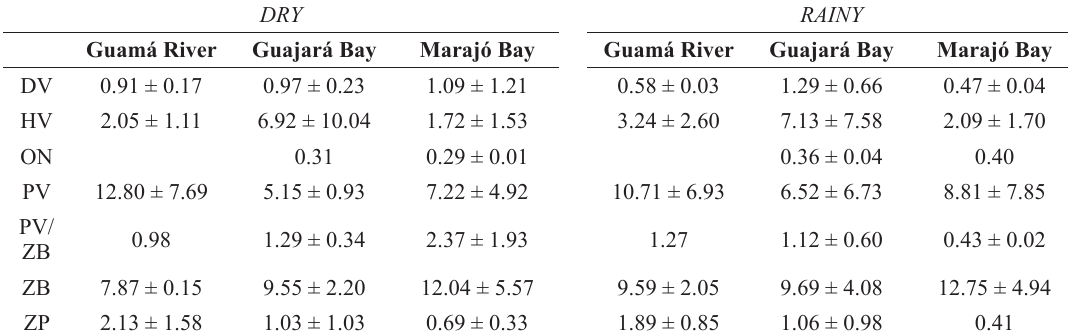
Mean ± S.D. Importance Values (IV) of estuary association fish feeding guilds by zone and season in the Guamá River, Guajará Bay and Marajó Bay. Detritivore (DV); Herbivore (HV); Omnivore (OP); Piscivore (PV); Piscivore/Zoobenthivore